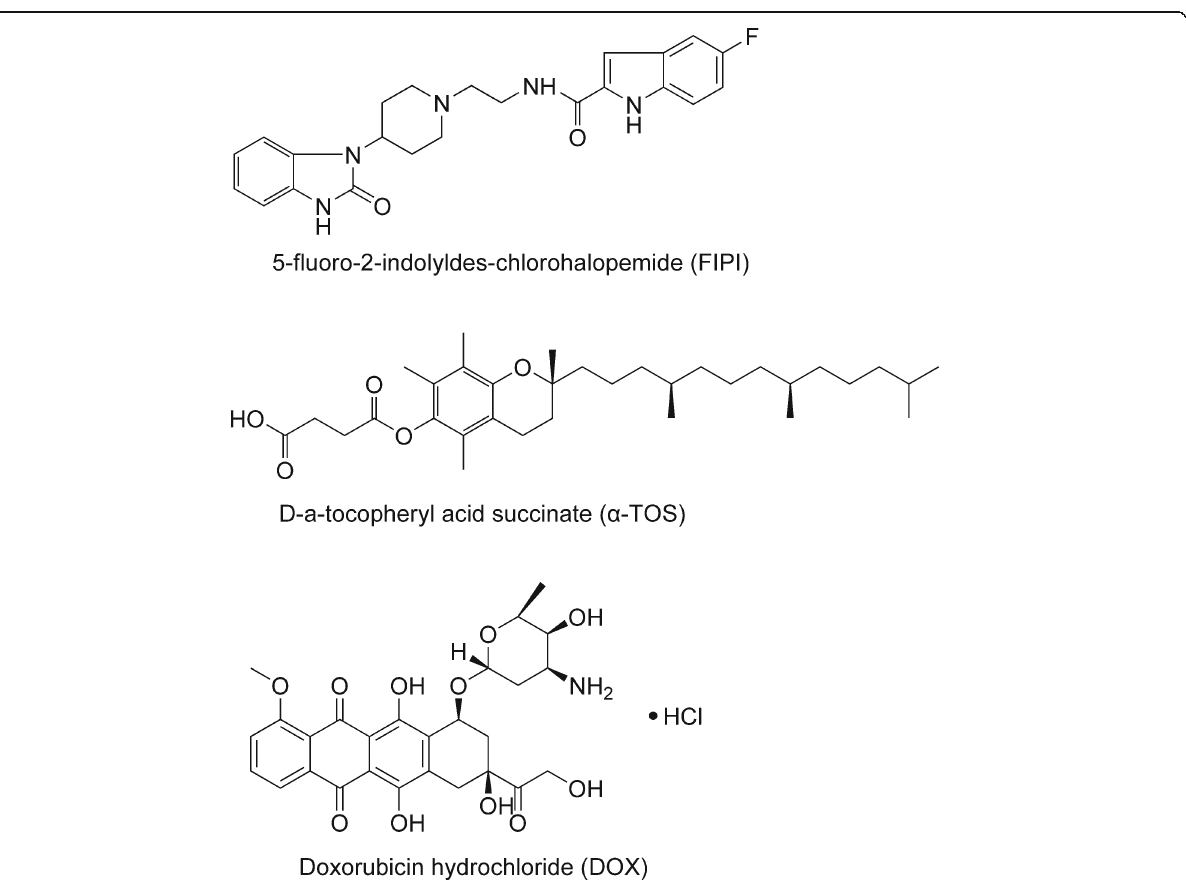
Fig. 1 Structural formulas of 5-fluoro-2-indolyldes-chlorohalopemide (FIPI), D- α -tocopheryl acid succinate ( α -TOS), and doxorubicin